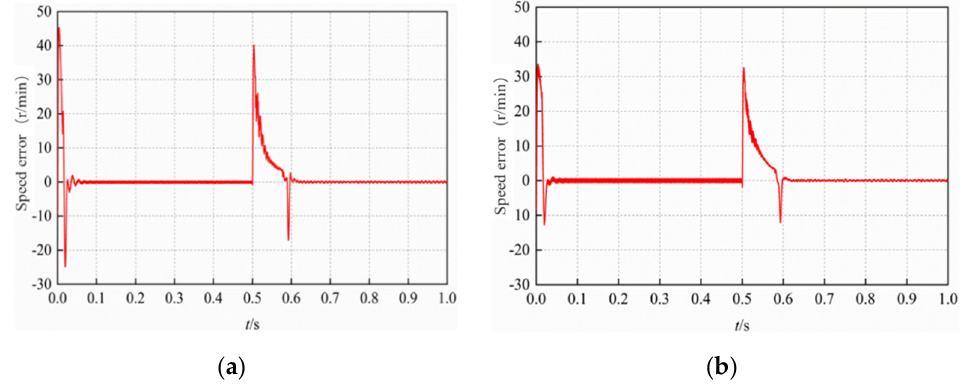
Figure 11. Simulation waveform of motor speed error with speed mutation. ( a ) Traditional MRAS algorithm. ( b ) STSM − MRAS algorithm.